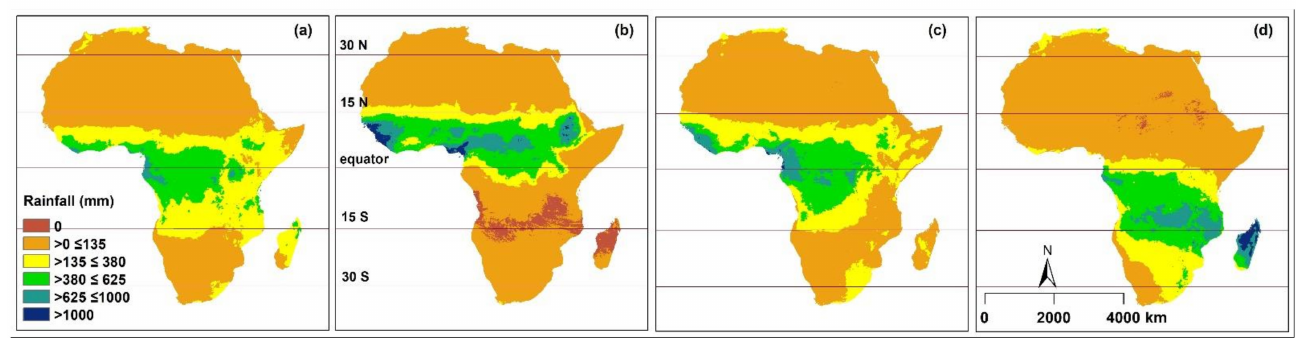
Figure 3. Spatial distribution of seasonal average rainfall (mm) across Africa from 1983 to